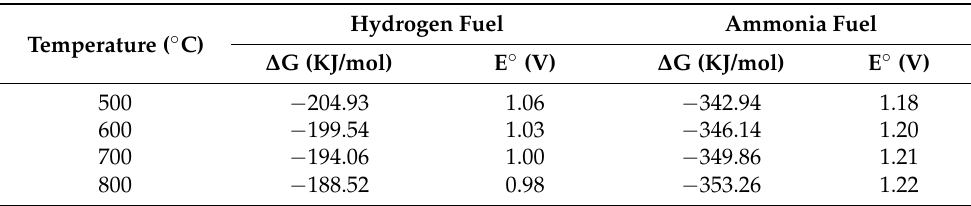
Table 1. Cell EMF for hydrogen and ammonia